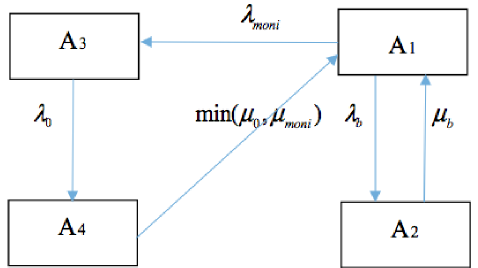
Figure 9. The multi-state Markov chain model incorporating the monitoring